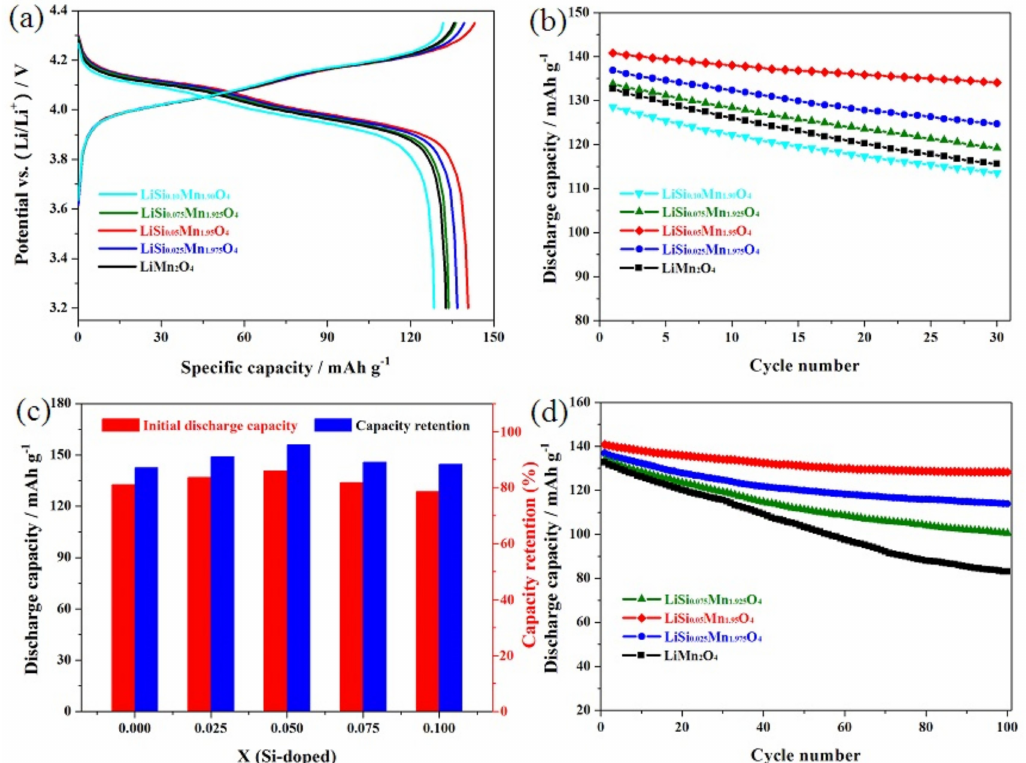
Figure 5. ( a ) Initial charge-discharge curves and ( b ) Cycling performance of the LiSi x Mn 2 − x O 4 (x = 0, 0.025, 0.05, 0.075 and 0.10) samples; ( c ) Comparison plots of the initial discharge capacities and capacity retentions; ( d ) Long Cycling performance of the LiSi x Mn 2 − x O 4 (x = 0, 0.025, 0.05, 0.075)